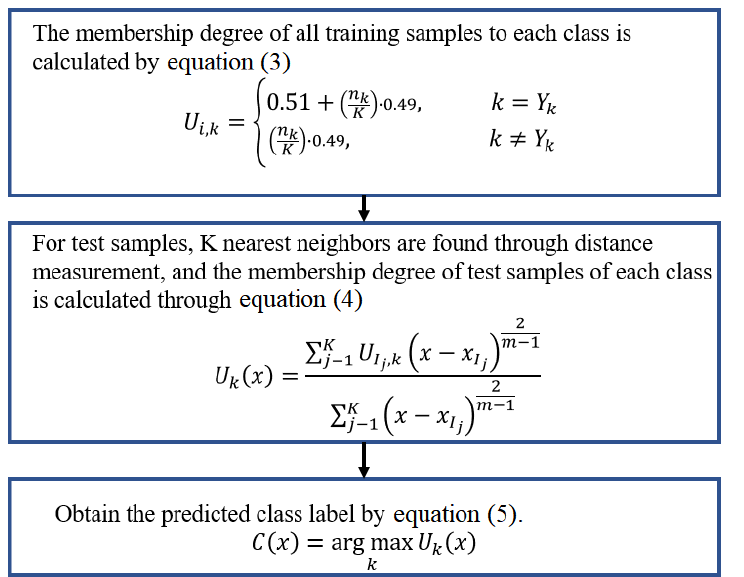
Figure 2. The flow chart of